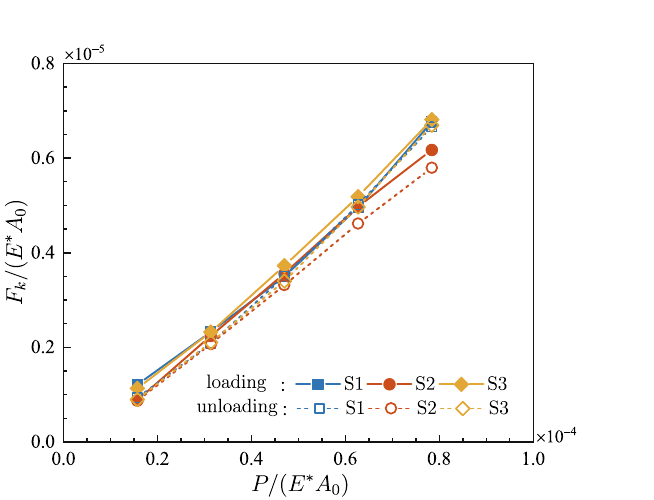
Figure 6. The dimensionless maximum static friction force F s /( E*A 0 ) at various dimensionless normal loads P / ( E*A 0 ).